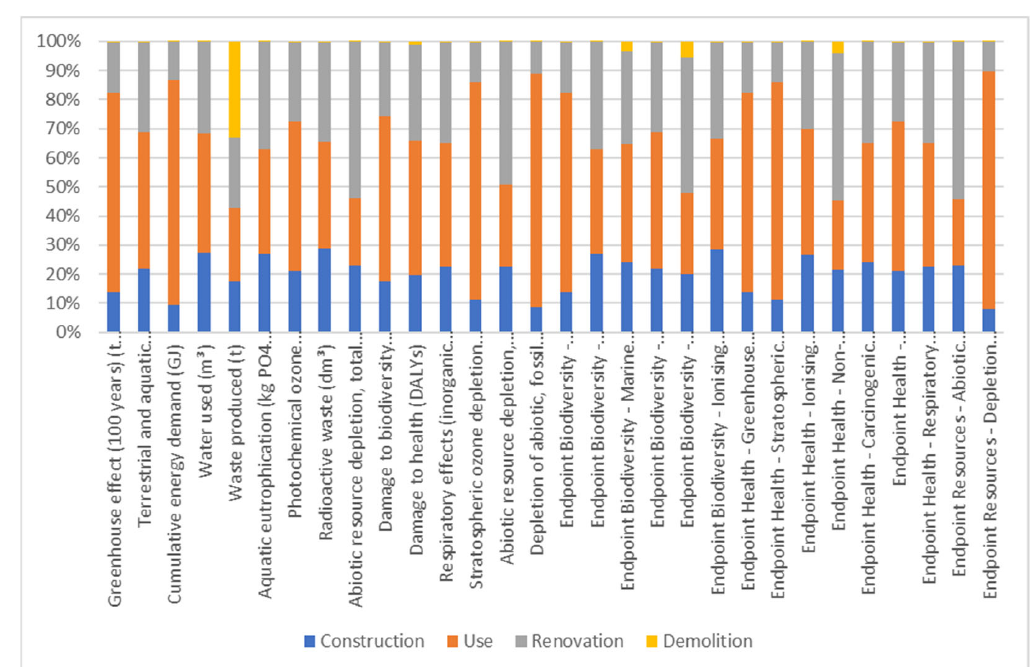
Figure 13. Impacts distribution according to life stage.